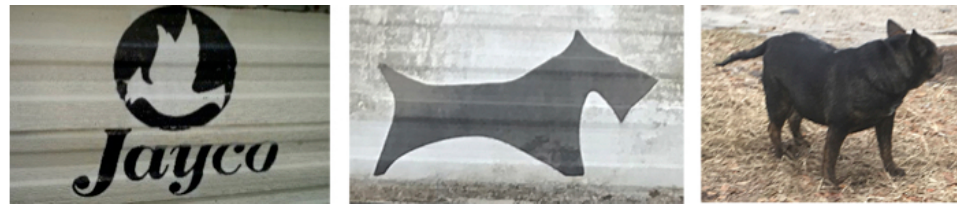
Figure 13. Emblematic Triptych, 2018.